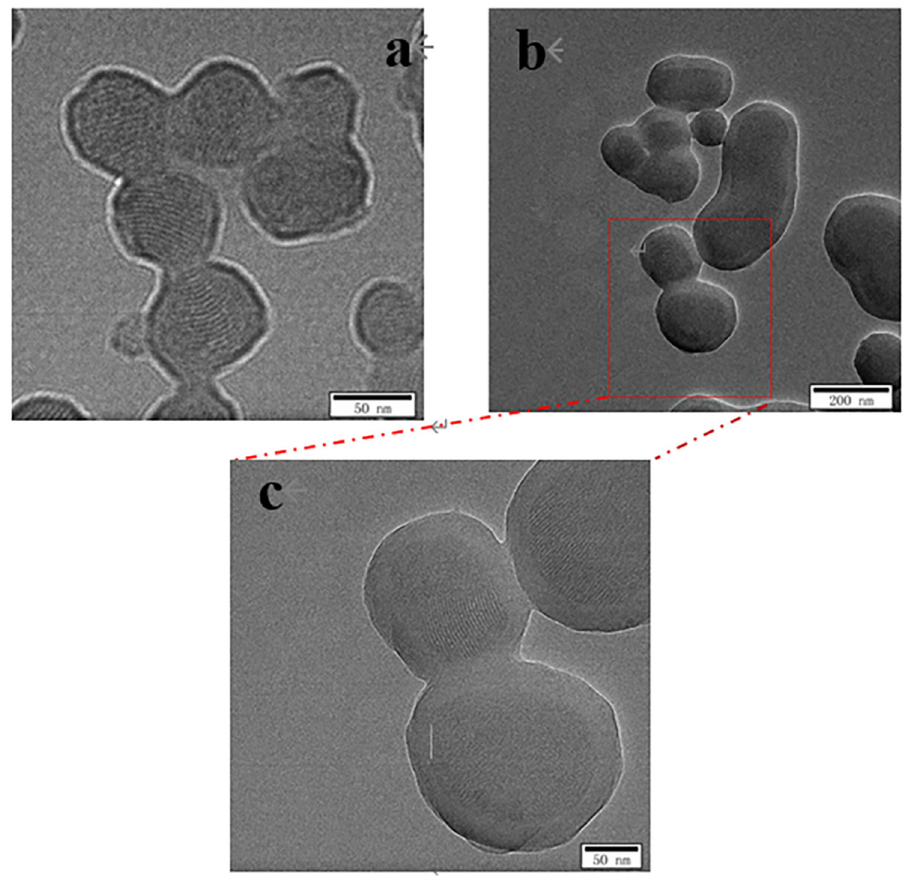
Figure 3: TEM images of ( a ) MSNs and ( b and c ) MSNs@MIPs.